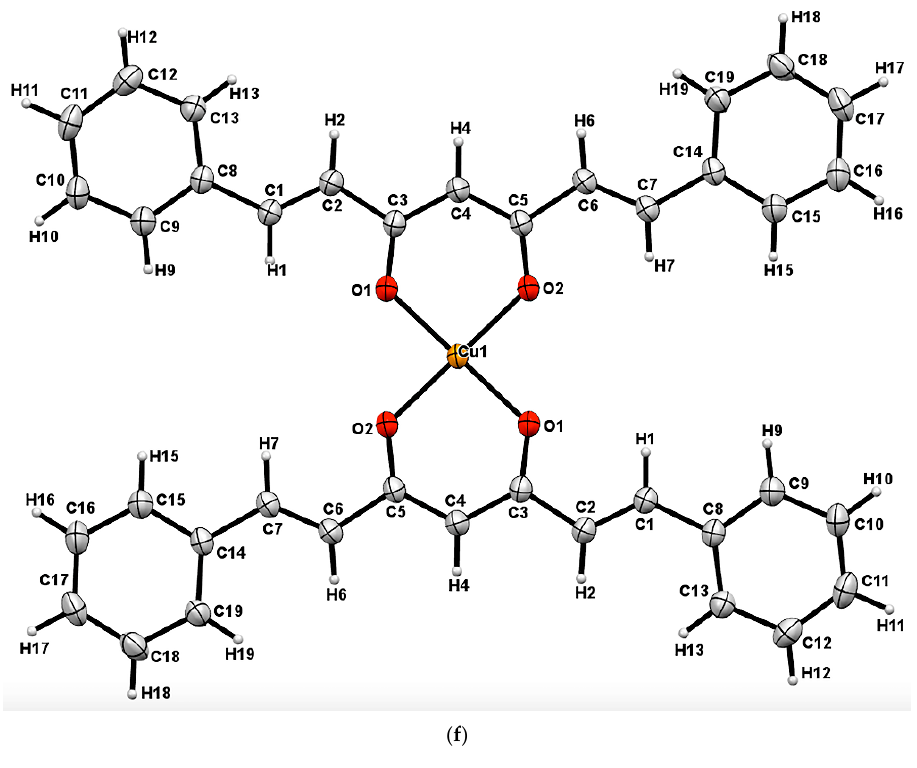
Figure 3. Crystal structures for 6 , 7 , 8 , 9a , 9b and 10 are shown in Figure 3 ( a ), ( b ), ( c ), ( d ), ( e ) and ( f ) with displacement ellipsoids at 30% probability